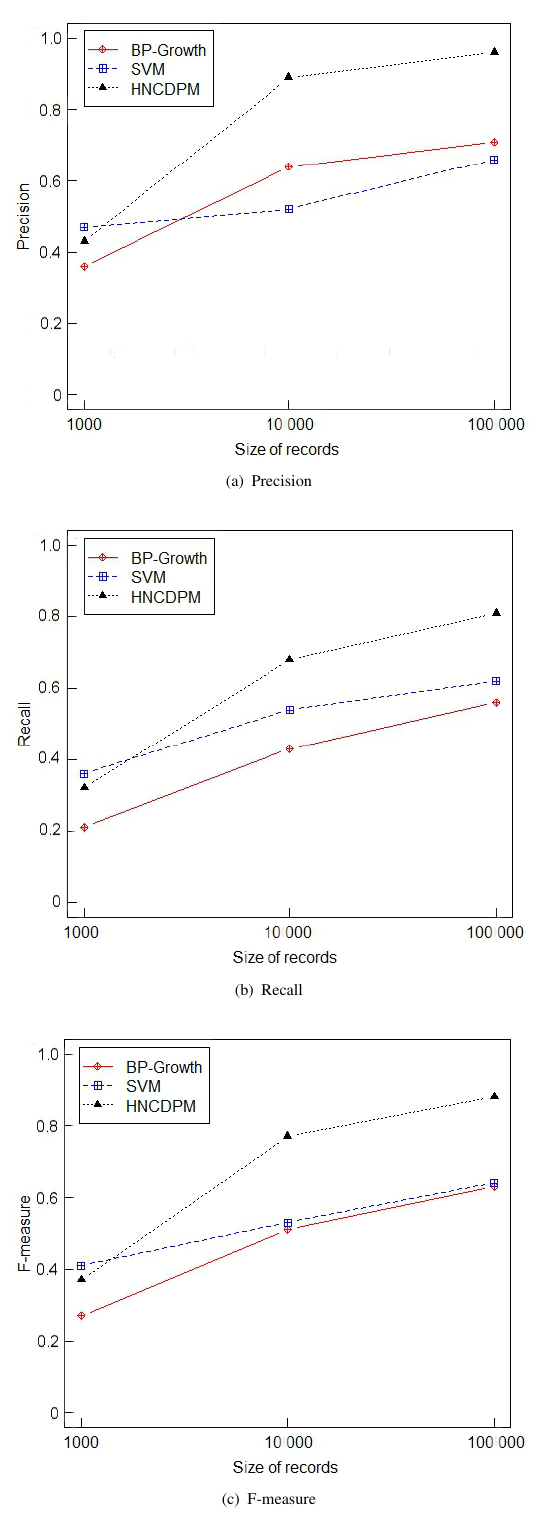
Fig. 8 Performance of HNCDPM compared with those of existing fraud detection methods. Our method shows an improved F-measure of over 20% compared with existing